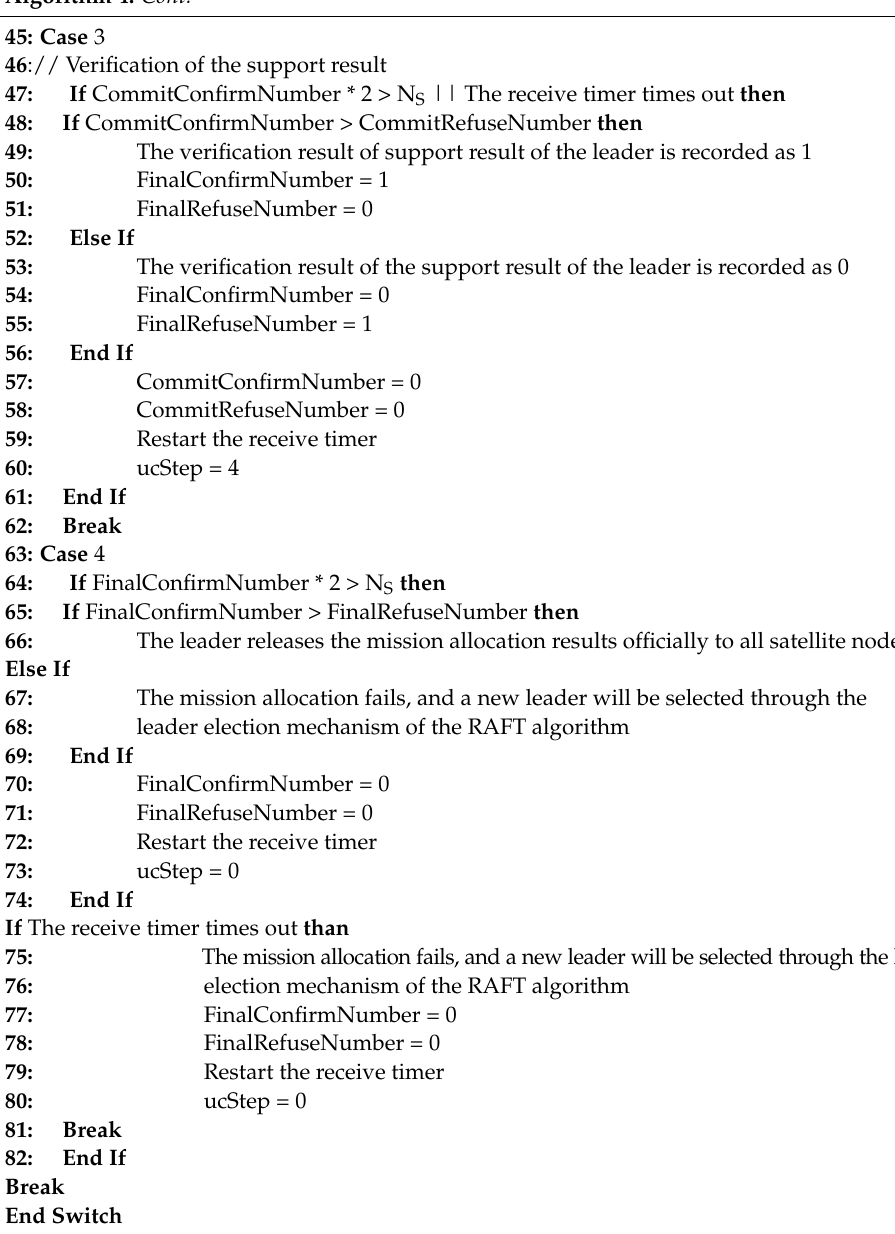
Algorithm 4. Cont.